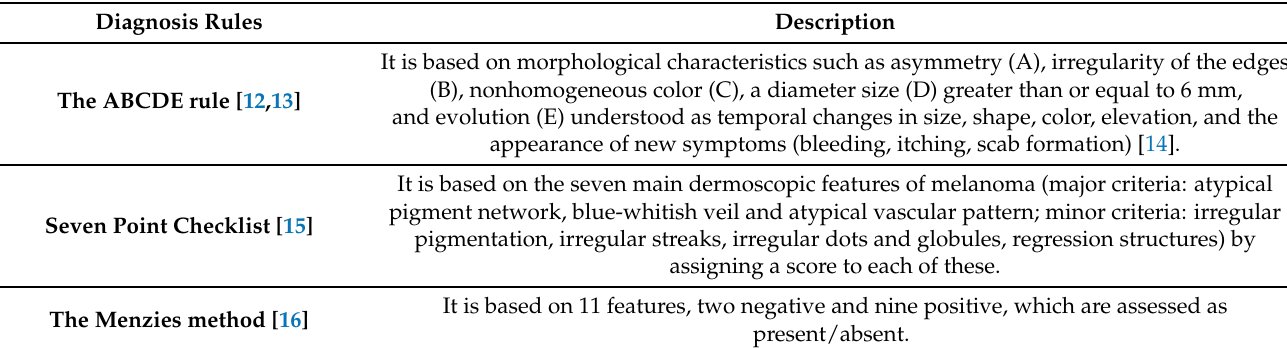
Table 1. Summary of the melanoma diagnosis